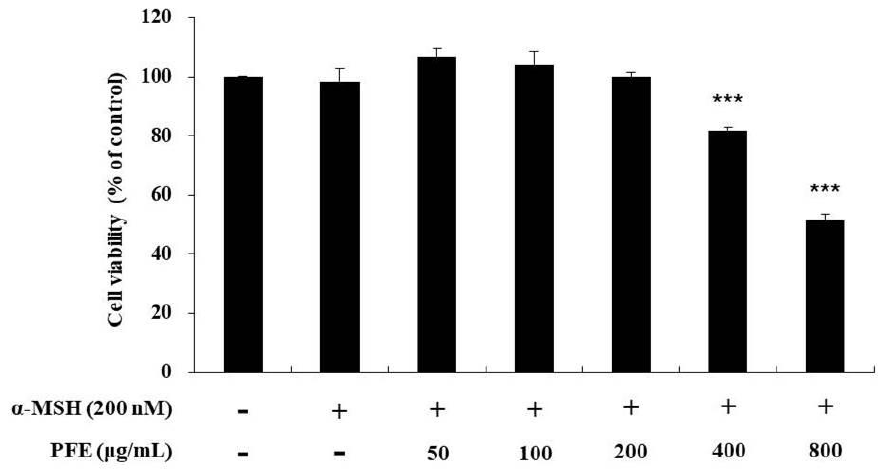
Figure 1. Variation in cytotoxicity of B16F10 cells to Paederia foetida L. extract (PFE) treatment con- centration. Results in the graph are represented as the mean ± SD of at least triplicate experiments. *** p < 0.001 vs non-treated cells.